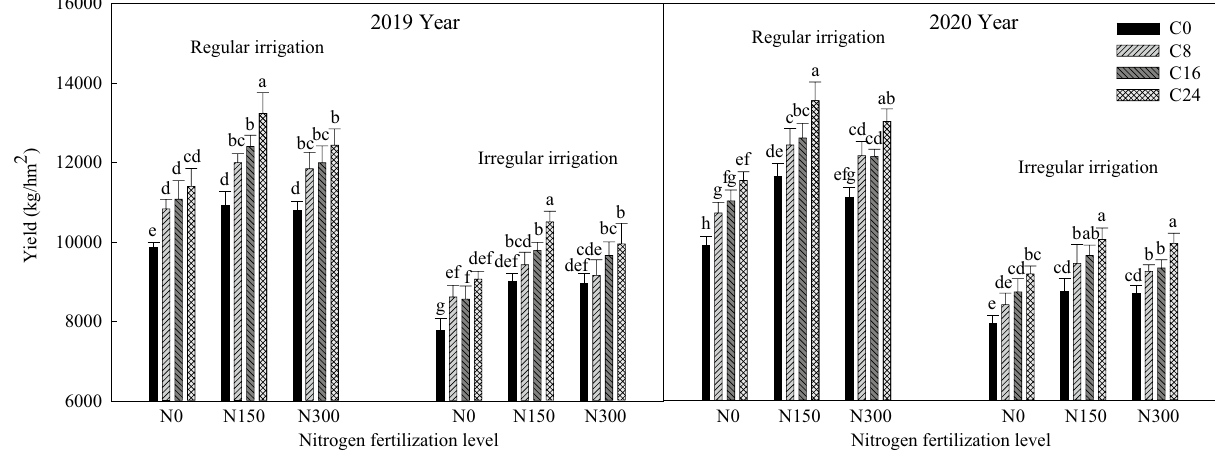
Figure 5. Effects of bio-char and nitrogen fertilizer on maize yield under different irrigation methods.